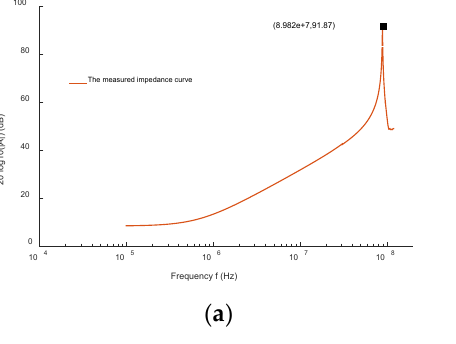
Table 2. Lumped parameters of the coil.